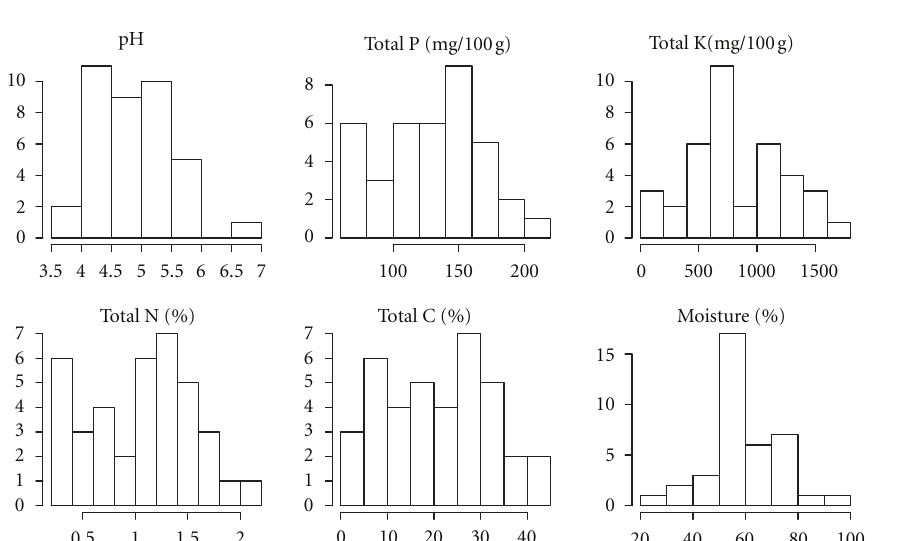
Figure 3: Frequency histograms of the 38 analyzed soil samples. The x -axis shows the ranges of the soil property and the y -axis the frequency.